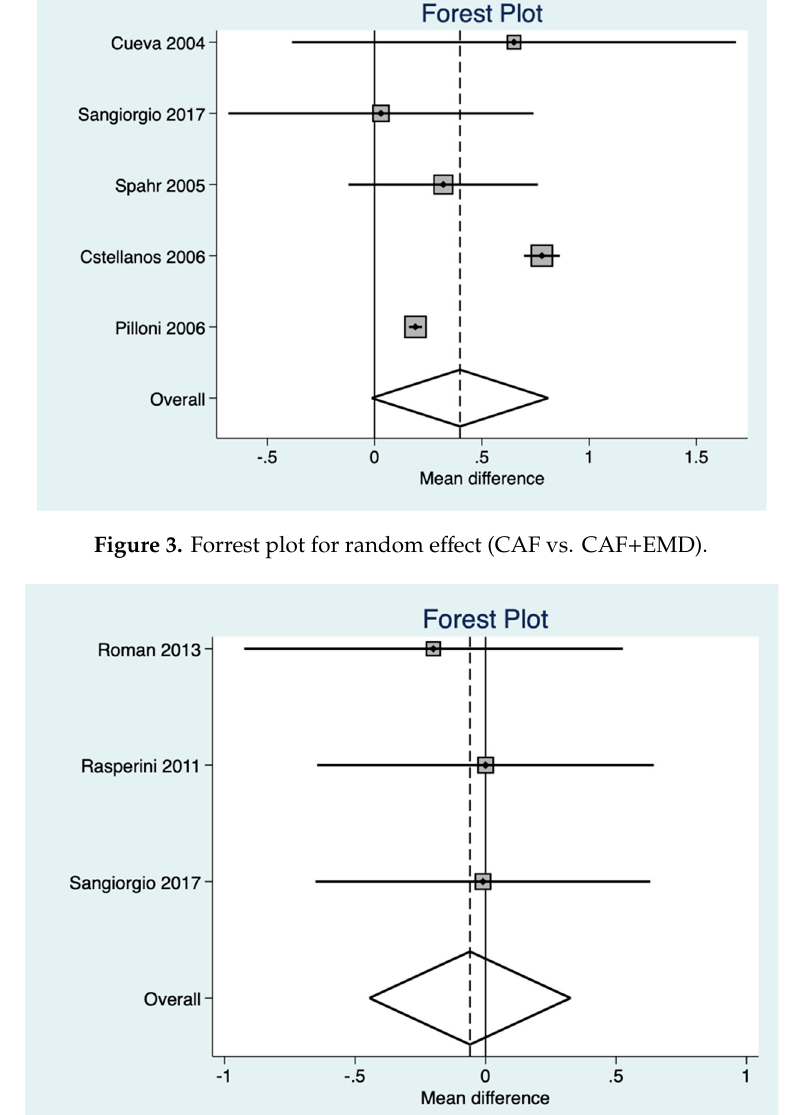
Figure 4. Forrest plot for random e ff ect (CAF + CTG + EMD vs. CAF + CTG).